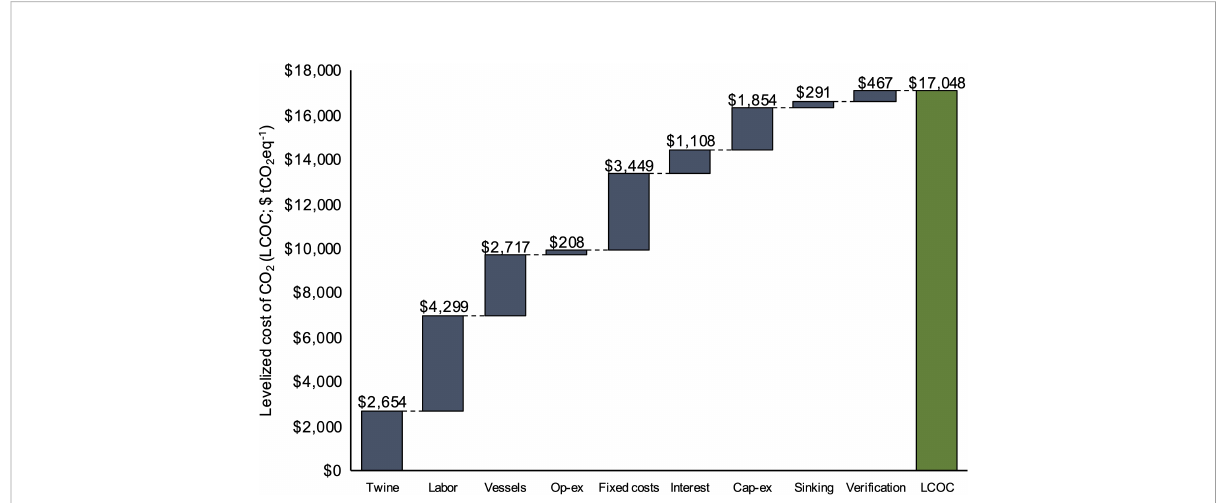
FIGURE 4 Breakdown of annual expenses within the baseline BTEM for LCOC ($ tCO 2 eq -1 ). The category “ Vessels ’’ includes only the contracted vessels required for typical farm operations. The category “ Sinking ” captures the cost of biomass transport to the sink site for CDR. The value above the dark blue bars represents the contribution of the speci fi c line item, while the value above the green bar displays the total